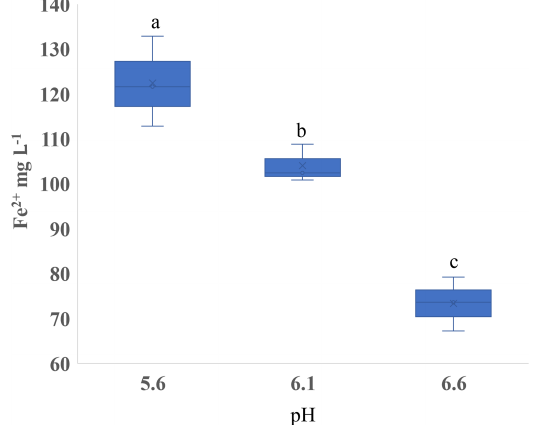
Table 4. Experiment 3. Methane gas data versus pH. Microcosms receiving hay in sandy loam (Experiment 3).